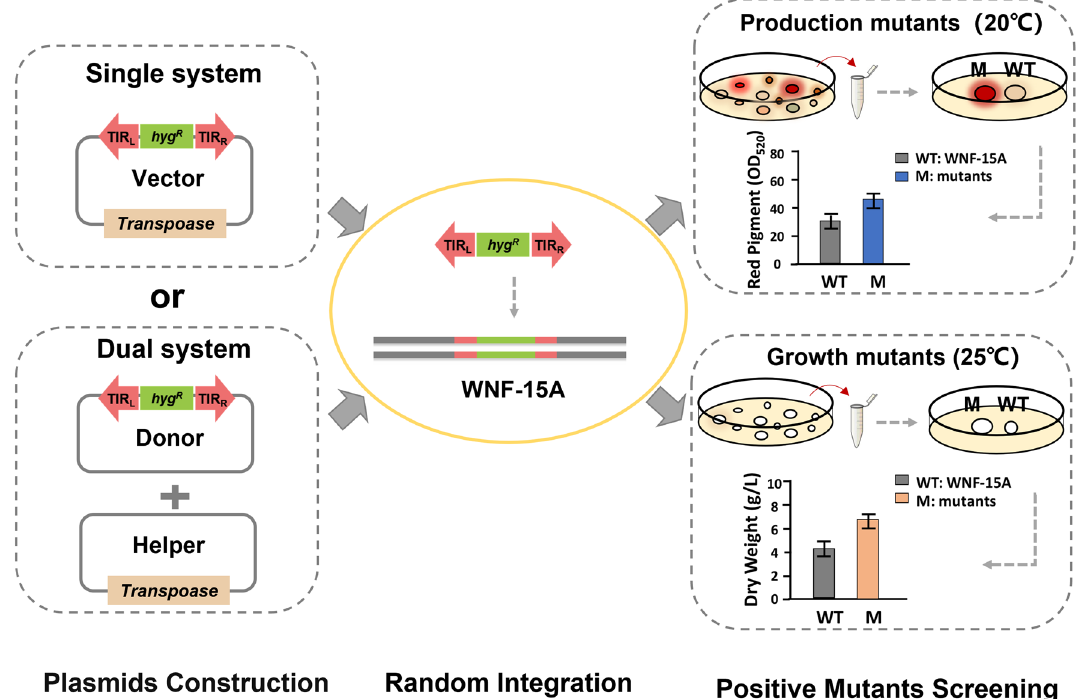
Fig. 1 Strategy for the construction of transposable systems and screening of the positive mutants. Single system owns a single plasmid carrying transposase gene cassette and a known fragment with hygromycin resistance gene ( hyg R ) and flanked by left ( TIR L ) and right ( TIR R ) terminal inverted repeats of transposons. Dual system consists of a donor plasmid with insertion fragment and a helper plasmid with transposase gene cassette. The transposase achieves transposition by excising the “known fragment” from the original plasmid and randomly integrating a new locus in host genome to select progeny changed in